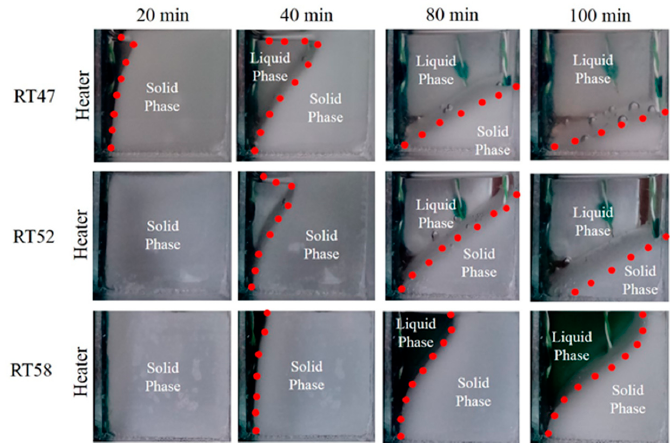
Figure 8. Melting profiles images for various PCMs at different time and 1.5 W heat input.